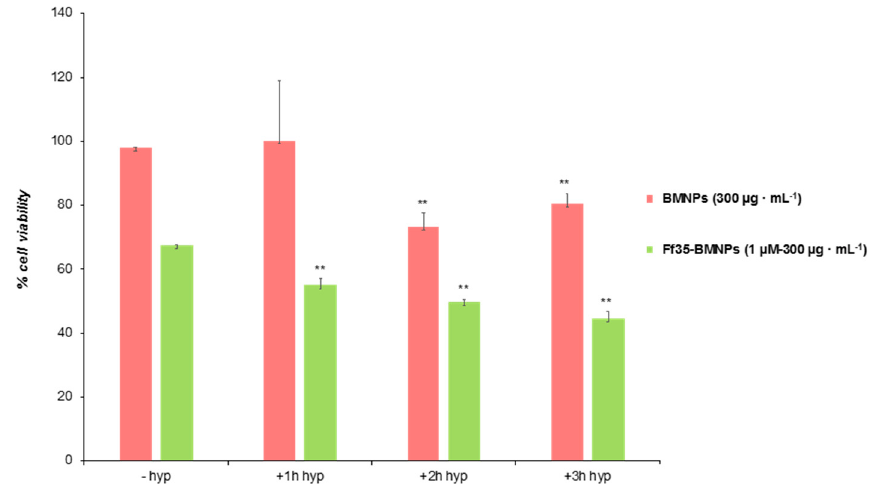
Figure 7. Effects of Ff35-BMNPs and hyperthermia on cell proliferation in HepG2 cells. HepG2 cells growing in log-phase were incubated with MEM/10% FBS in the absence or presence Ff35-BMNPs (concentration of Ff35 was 1 μ M and BMNPs was 300 μ g mL − 1 ) for 24 h, and exposed to an alternative magnetic field for 1, 2, or 3 h. Cell number was determined by the MTT assay and expressed as percentage of control cells. Percentage of viability is normalized to that for the control cells. Results represent the mean ± SEM of three independent experiments conducted in triplicate. ** p < 0.001, when compared with their respective control values.